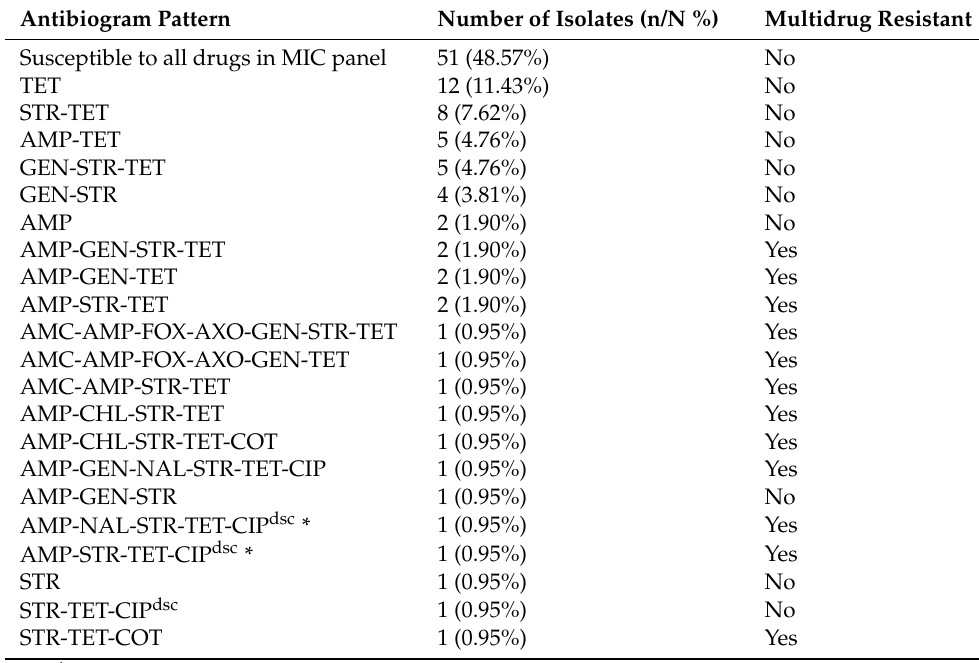
Table 4. Distribution of phenotypic antibiogram patterns in E. coli isolates (n =